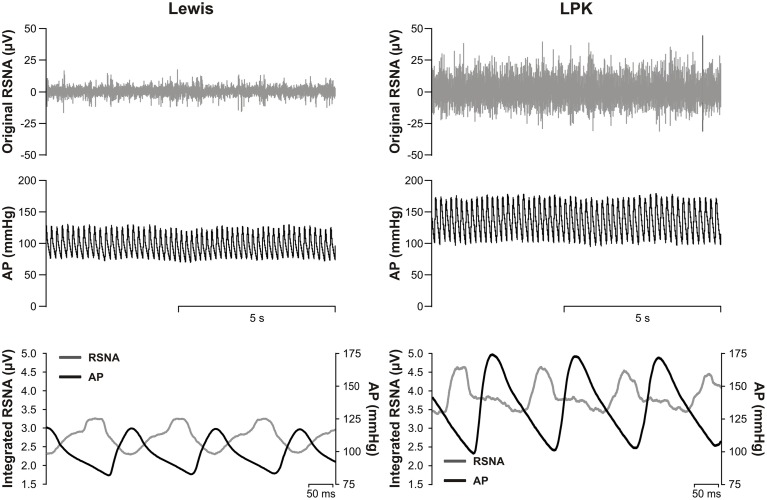
Top, representative raw data traces of original renal sympathetic nerve activity (RSNA) and arterial pressure (AP) from conscious Lewis (left) and Lewis Polycystic Kidney (LPK, right) rats. Bottom, pulse modulation of RSNA using pulse triggered averages of AP and integrated RSNA (solid lines) from the same Lewis (left) and LPK (right) animals. Note the inverse phasic relationship between AP and RSNA in the pulse-triggered averages, typical of pulse modulation of SNA.